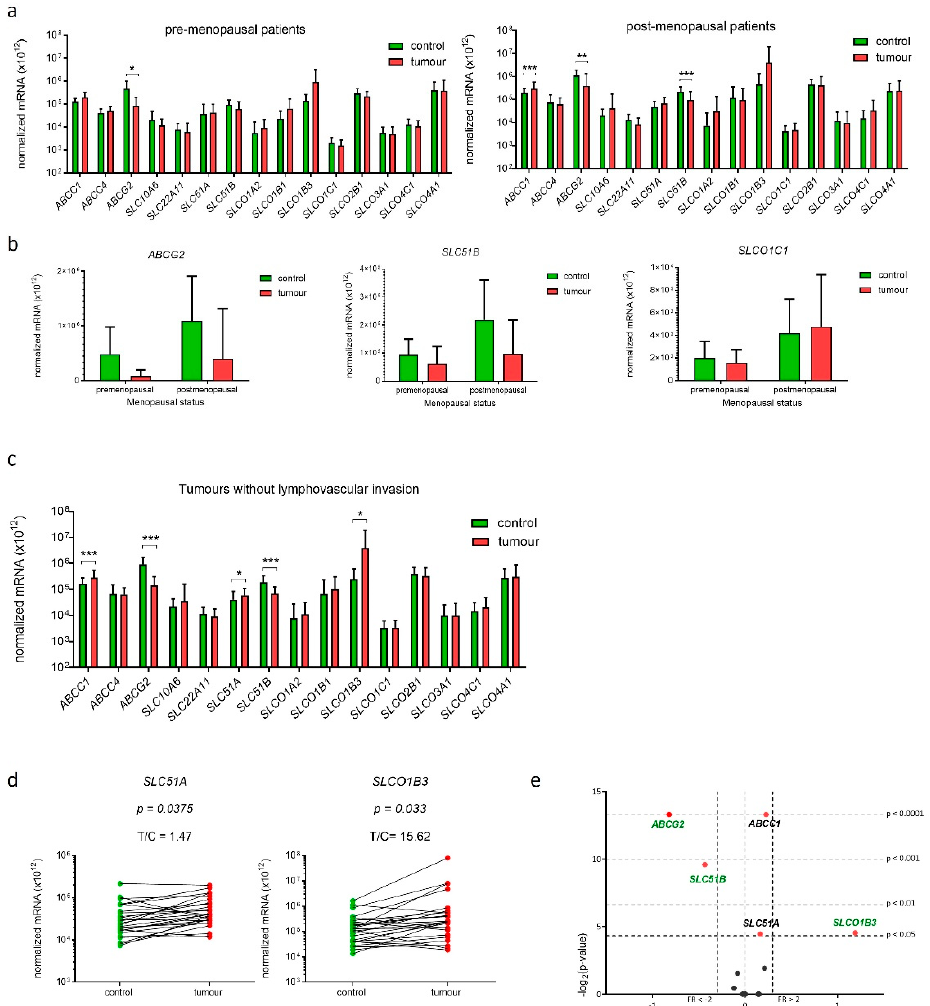
Figure 5. Expression of genes encoding E1-S transporters in paired tissue samples from premenopausal and postmenopausal patients and patients without lymphovascular invasion. ( a ) Expression in tissue samples from premenopausal patients ( n = 11) and tissue samples from postmenopausal patients ( n = 25). (Wilcoxon matched pairs with Bonferroni`s mul- tiple comparison test). ( b ) Effects of menopausal status on expression of three genes: ABCG2 , SLC51B and SLCO1C1 ( two- way ANOVA). ( c ) Expression of genes in samples from patients without lymphovascular invasion ( n = 27) (Wilcoxon